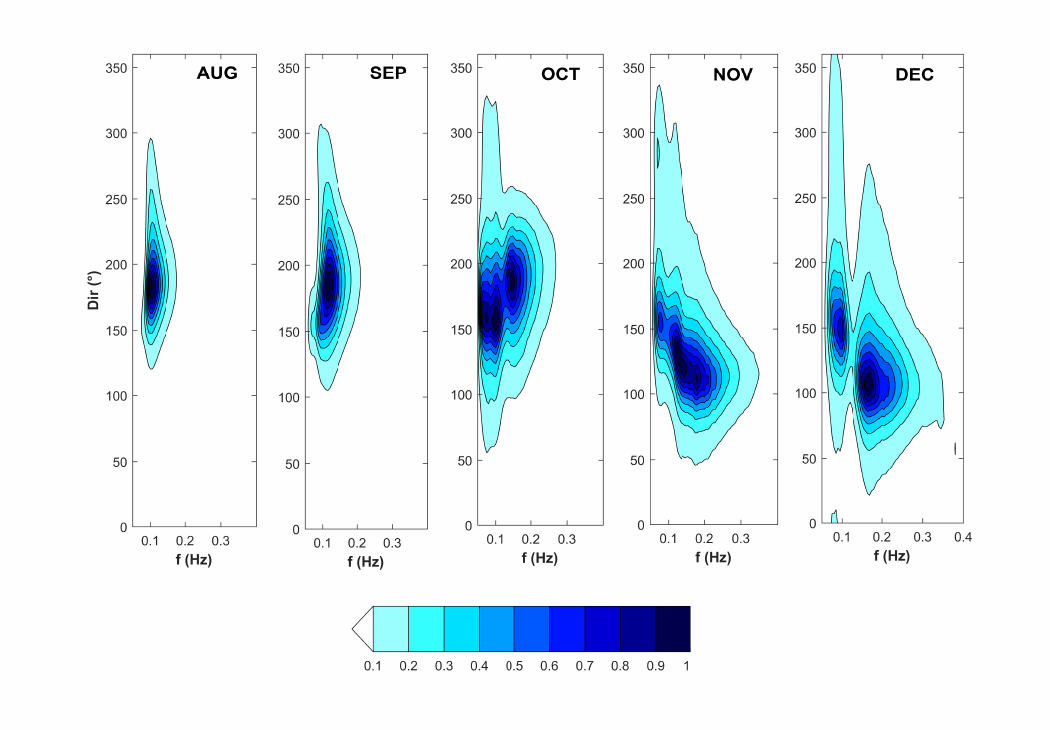
Figure 7. Monthly average wave directional spectra. Spectral energy values normalized with respect to peak energy